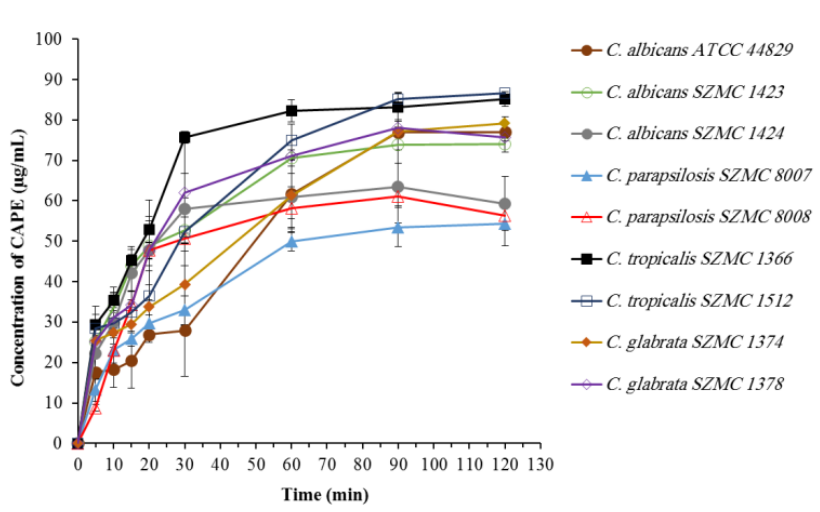
Figure 3. Cellular uptake of CAPE by nine Candida strains. Data are shown as mean ± SD from three independent experiments.